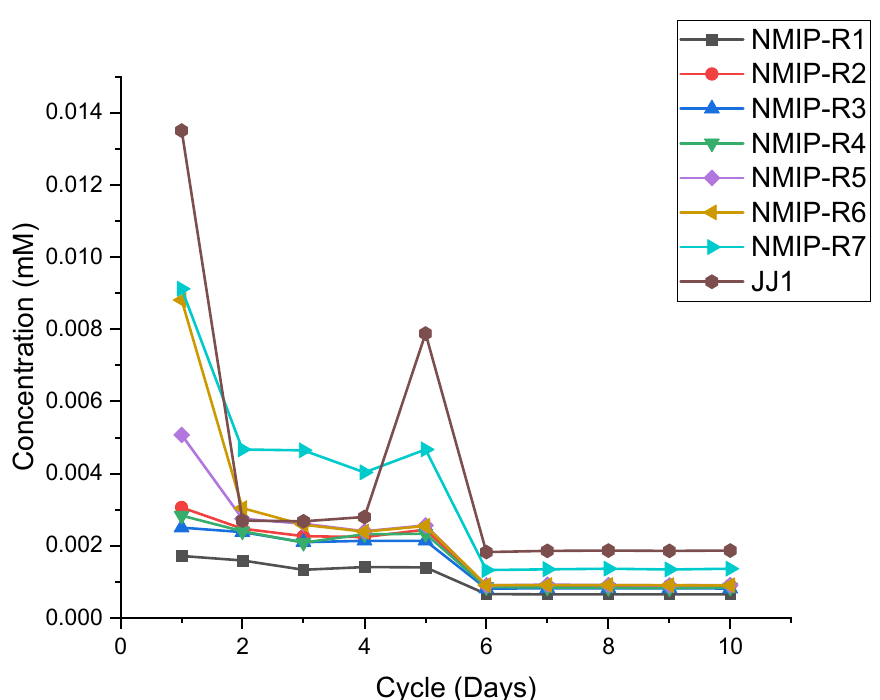
Figure 6. Demonstrating the NMIP release and uptake kinetics, compared to JJ1. The concentration of Timolol, in mM, is shown on the y -axis. The x -axis demonstrates the cycle (in day) of measure- ment.